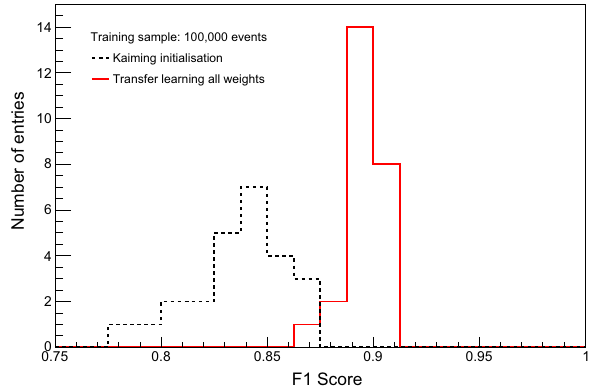
Fig. 4 F1 score distributions from the ensembles of 25 trained net- works using the transfer learning all weights method (red) and the Kaiming-initialised networks (black). In both cases the networks were trained using the same 100,000 events